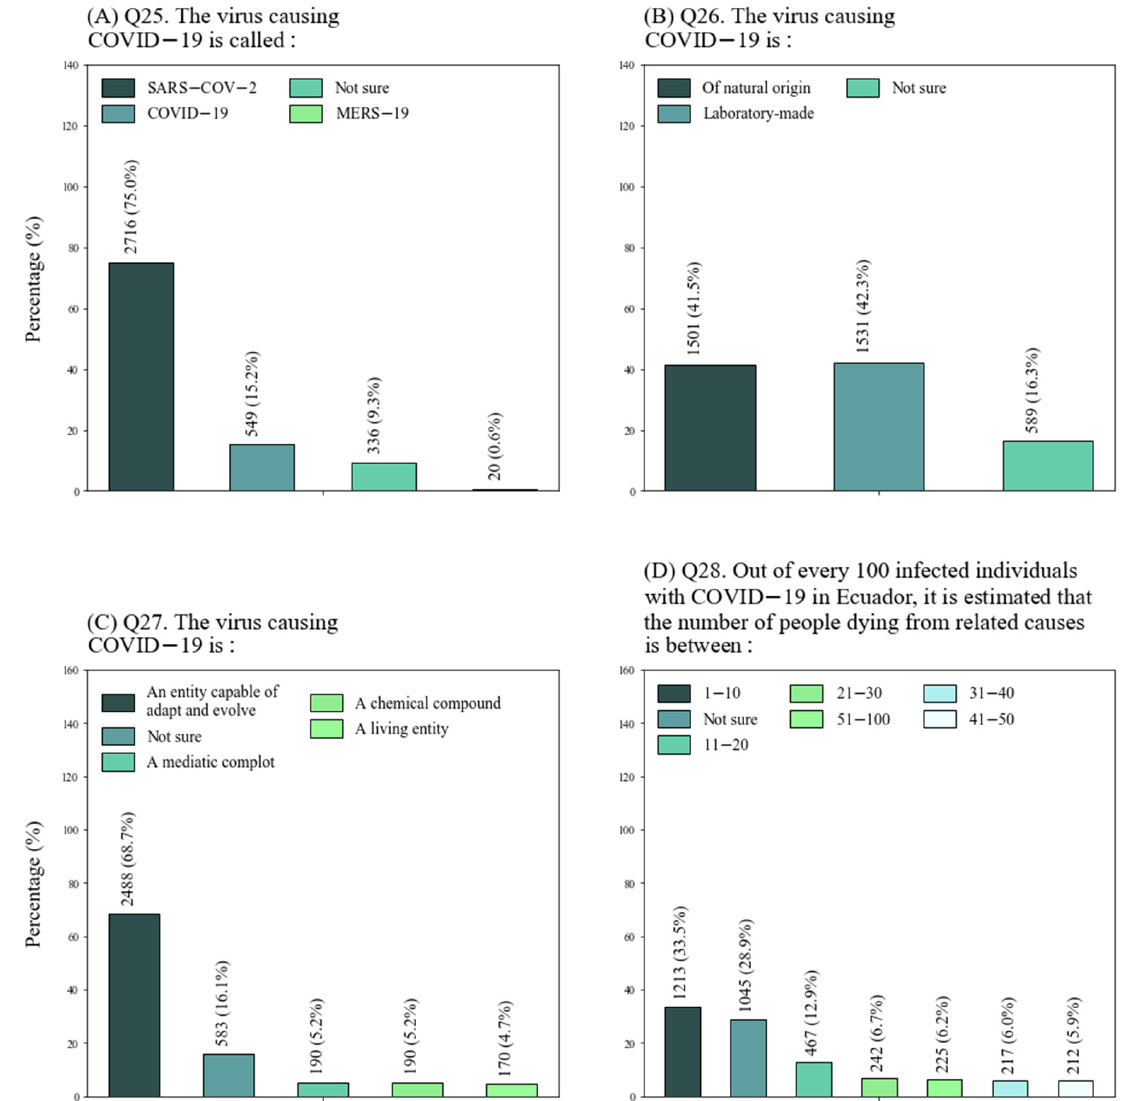
Figure 2. Percentages for multiple-option questions. ( A ) Question 25; ( B ) Question 26; ( C ) Question 27; ( D ) Question 28.